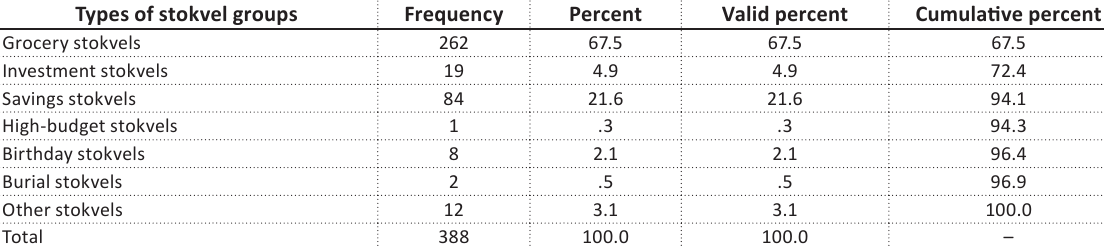
Table 5. Response on types of stokvel groups